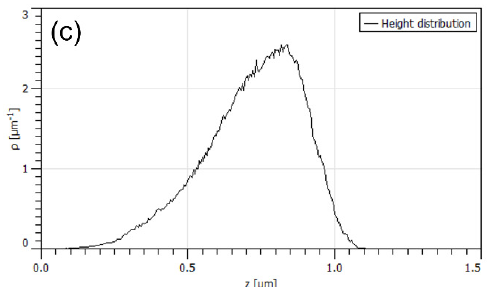
Figure 7. ( a ) Three-dimensional AFM image, ( b ) profile and ( c ) height distribution of the Si imprint stamp. The red line indicates the location where the AFM profile was extracted.